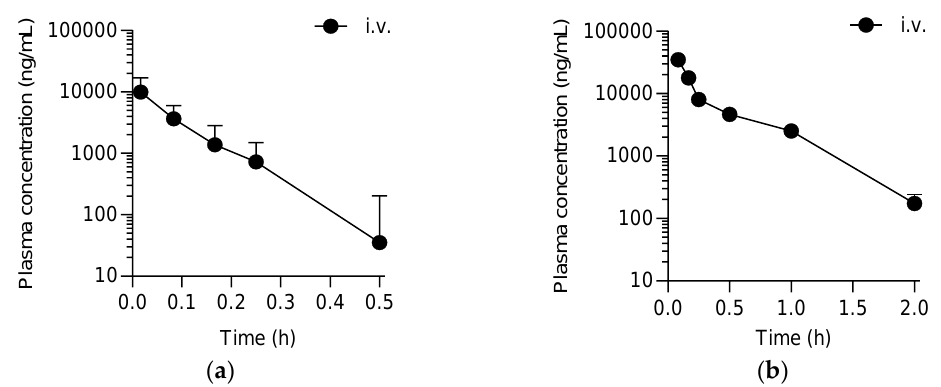
Figure 1. Plasma concentration-time profiles of SP-8356 following a single i.v. and p.o. dose in ( a ) rats and ( b ) dogs. SP-8356 was dosed i.v. and p.o. to male ( a ) Sprague-Dawley (SD) rats and ( b ) Beagle dogs at (20 and 50) mg / kg, respectively. Plasma concentration of SP-8356 was determined for 24 h post-dosing. Each point represents mean ± standard deviation (S.D.) ( n = 6). After the p.o. administration in both rats and dogs, SP-8356 was not detected in the plasma throughout the time course. Table 1. Plasma pharmacokinetic parameters of SP-8356 following a single i.v. and p.o. dose in rats and dogs.